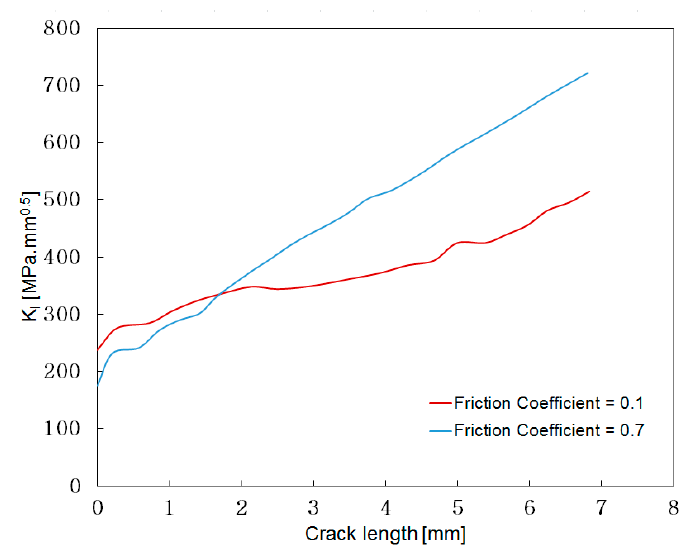
Figure 25. Crack propagation behavior with low and high metal-to-metal friction coefficient. The geometry is a 45° short flank, 95% crack front.